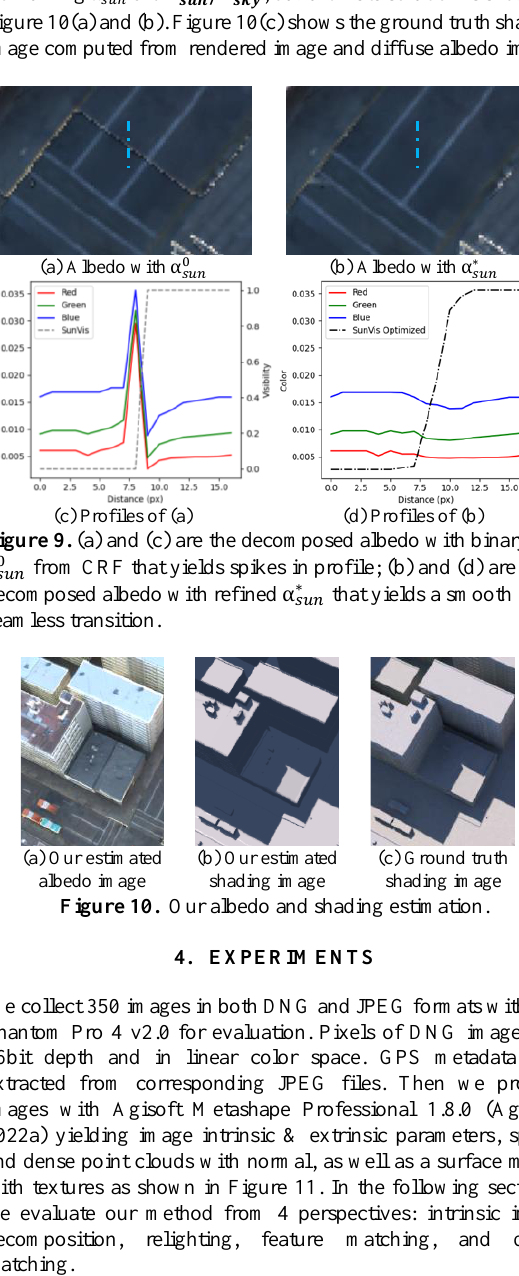
Figure 12. Qualitative comparison of albedo decomposition. (a) Raw image, (b) InverseRenderNet v2, (c) SMGAN, (d)